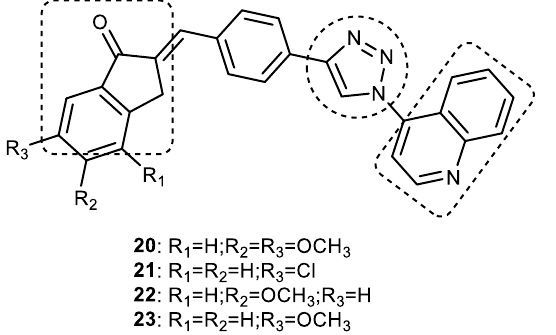
Figure 13. Chemical structures of quinoline-1,2,3-triazole-indanone trihybrids.